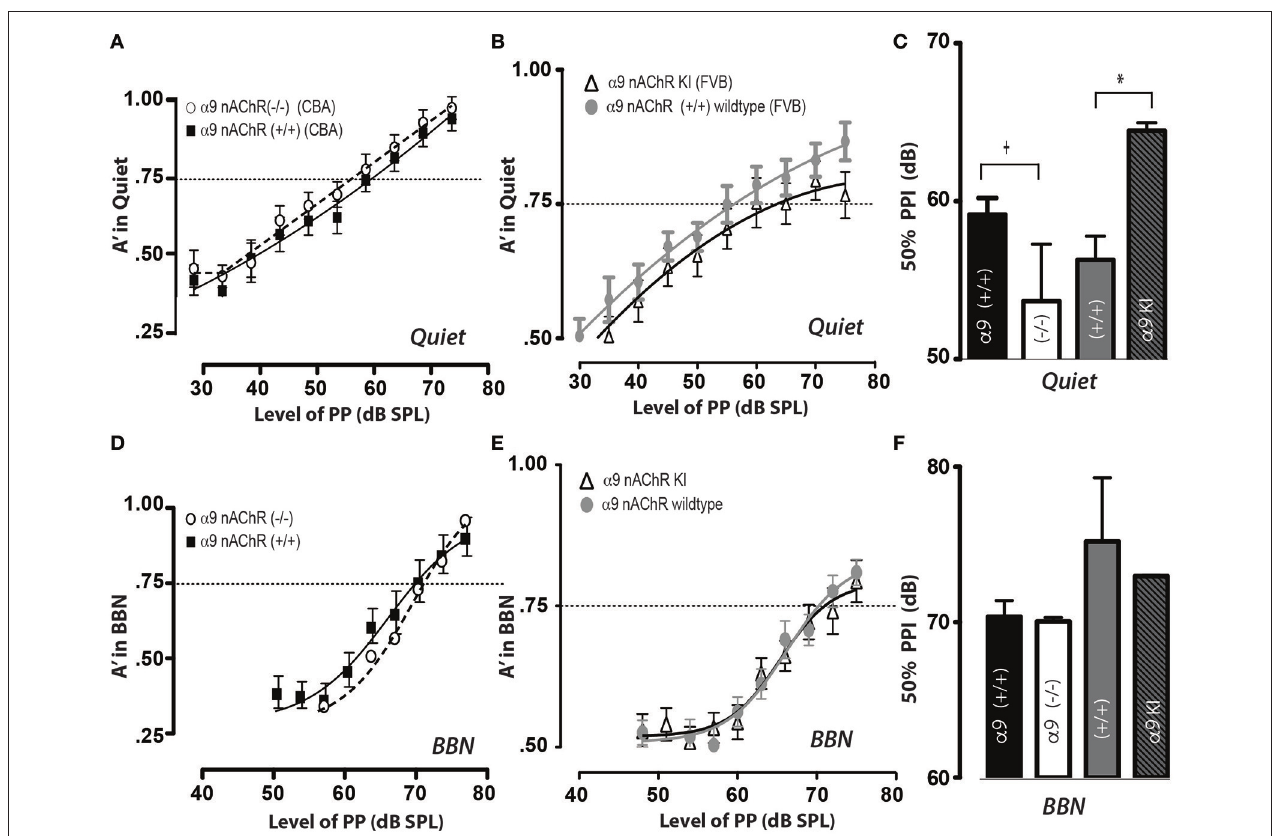
FIGURE 5 | Prepulse inhibition thresholds in quiet are modified in opposite directions by the loss (–/–) or increased activity Ld’T (KI) of α 9 nAChRs, yet responses do not differ significantly in background noise. In quiet, (A) α 9 nAChRs (–/–) or (B) Ld’T KI animals can inhibit their acoustic startle with a prepulse at 80 dB, and did not inhibit their startle with a prepulse at 30 dB (edges of psychometric function). However, the threshold for inhibiting their startle response 50% of the time (A ′ = 0.75) is higher for α 9 (–/–) null animals (A) and lower for α 9 KI animals (B) (C) Mean PPI thresholds (defined as prepulse level at A ′ = 0.75) and SEM values are shown for (A) α 9 nAChRs (–/–) or B) Ld’T KI, and each of the groups contained 12 mice. There was a significant threshold increase for α 9 nAChR KI animals when compared to littermate controls) and there was a trend for α 9 nAChRs (–/–) to have lower thresholds in quiet ( t , trend; * p < 0.05). (D,E) When prepulse inhibition of the acoustic startle reflex was tested in 60 dB background noise (BBN), α 9 nAChRs (–/–) or Ld’T KI mice were able to inhibit their startle reflex when tested with a prepulse of 80 dB, but did not inhibit their startle with a prepulse at 50 dB; yet unlike the quiet condition, there was no significant difference between (D) α 9 nAChR (–/–) or (E) Ld’T KI mice in their response, as shown in bar graph form with means and SEMs in (F)